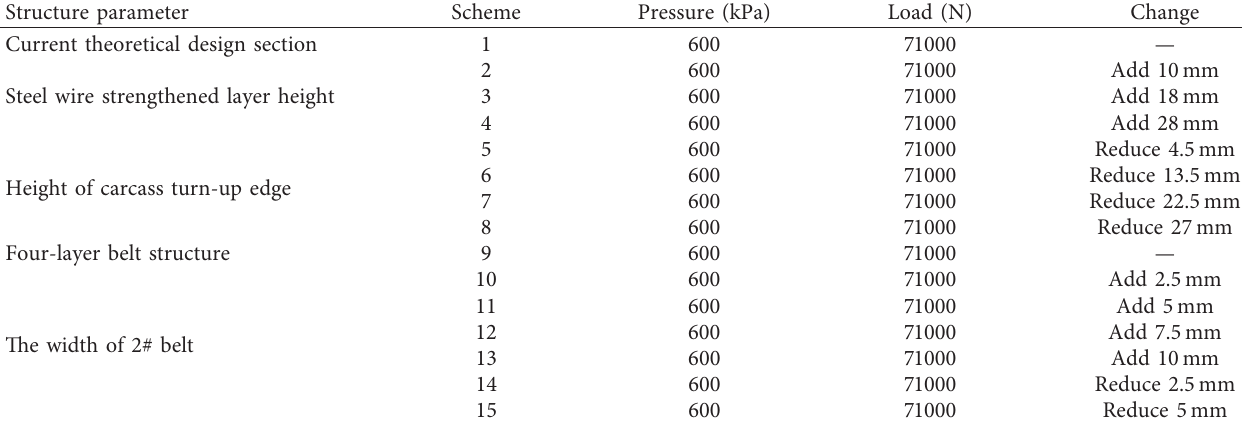
Table 3: Structural sensitivity design.